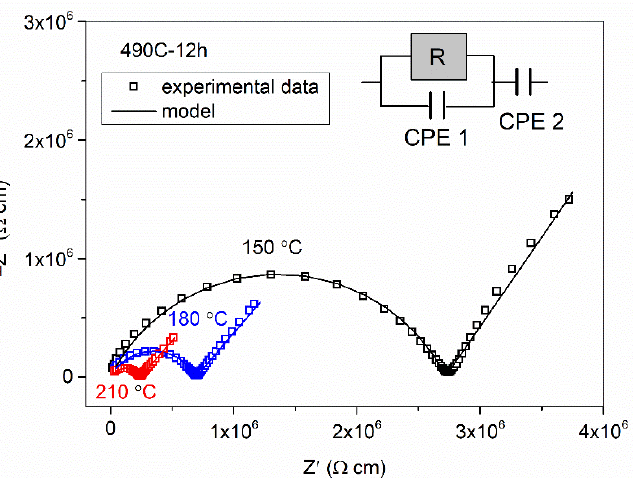
Figure 3. Nyquist plot of glass-ceramic prepared at 490 °C for 12 h measured at 150, 180 and 210 °C in dry nitrogen.